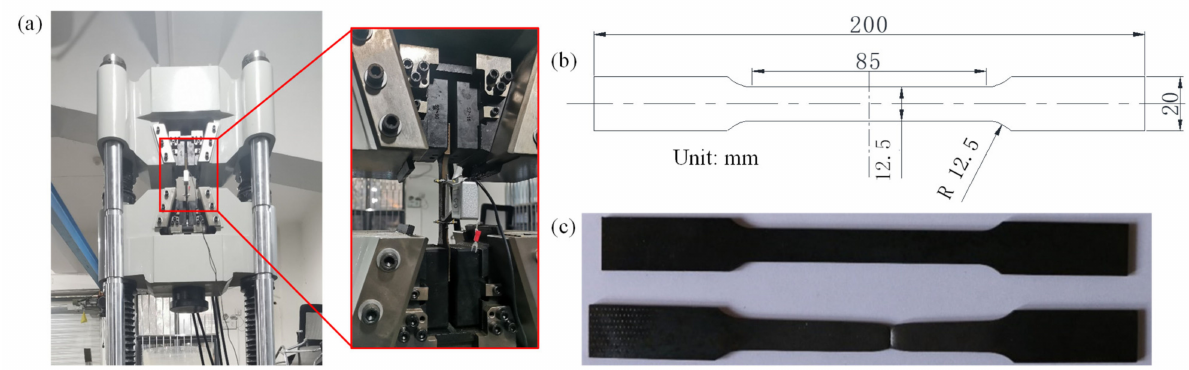
Figure 5. The finite element model of low velocity impact (the red arrows mean that the freedoms of the boundary in three directions have been fixed).